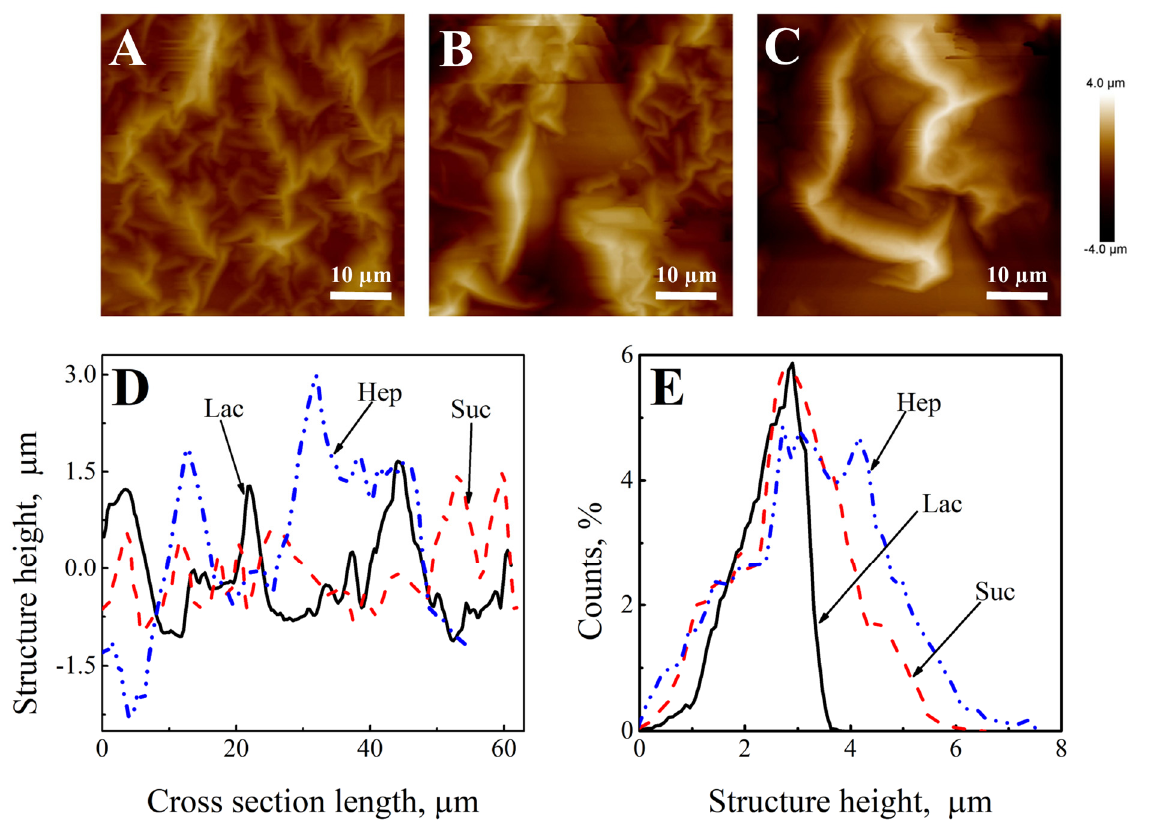
Figure 3. The AFM-based evaluation of surface morphology dominant features of ( A )—(Ppy-PMB) Lac ; ( B )—(Ppy-PMB) Suc ; ( C )—(Ppy-PMB) Hep . ( D )—The comparison of the cross-sections of surfaces of the layers. ( E )—Height distribution. Electrochemical deposition conditions are indicated in Figure 1.